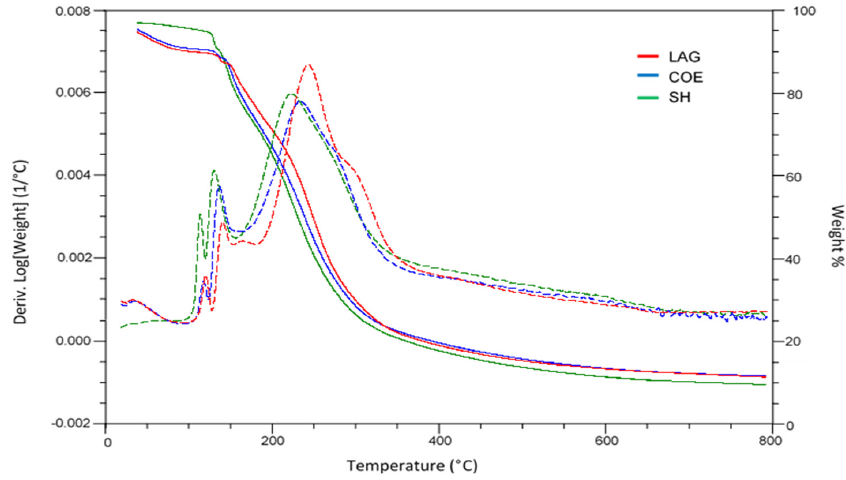
Figure 3. TG (solid lines) and first derivative (dotted lines) curves of iodine/HP- β -CD complexes